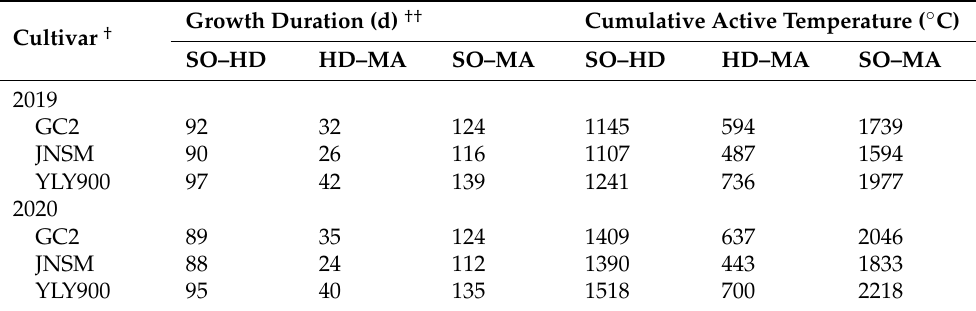
Table 1. Growth duration and cumulative active temperature of three rice cultivars grown in